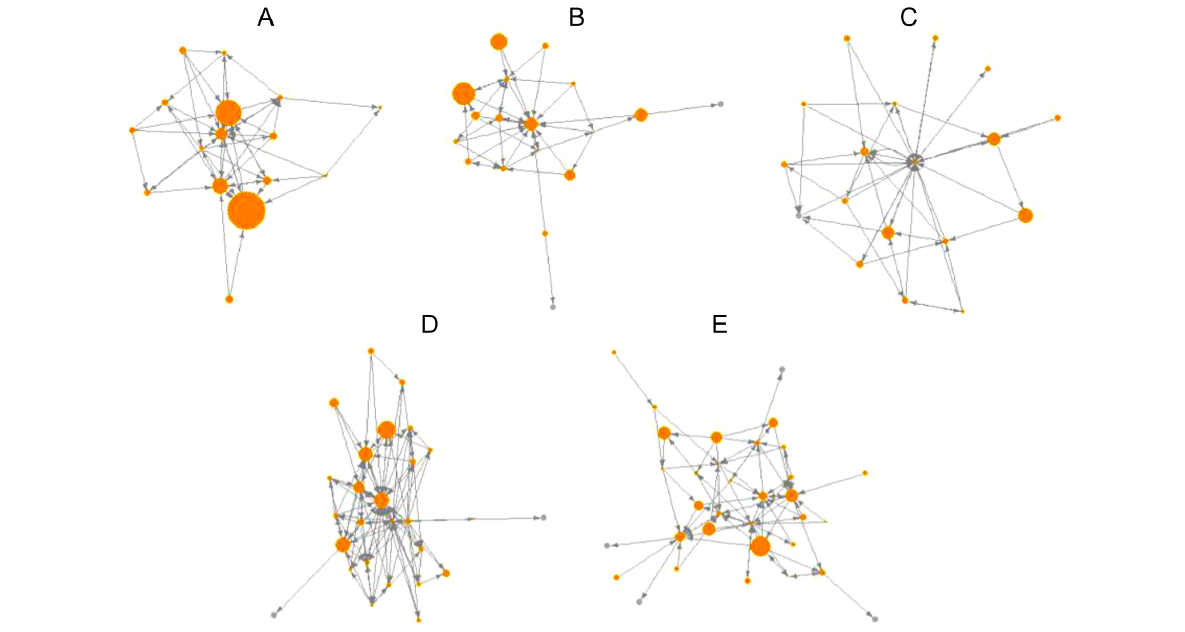
Fig. 3 . Information-sharing networks in the five communities (A-E). Node sizes correspond to the biomass per hectare on the farmer’s plot. Gray nodes represent community members who could not be interviewed and whose biomass data are not available. Arrows point from the information recipient to the information provider.